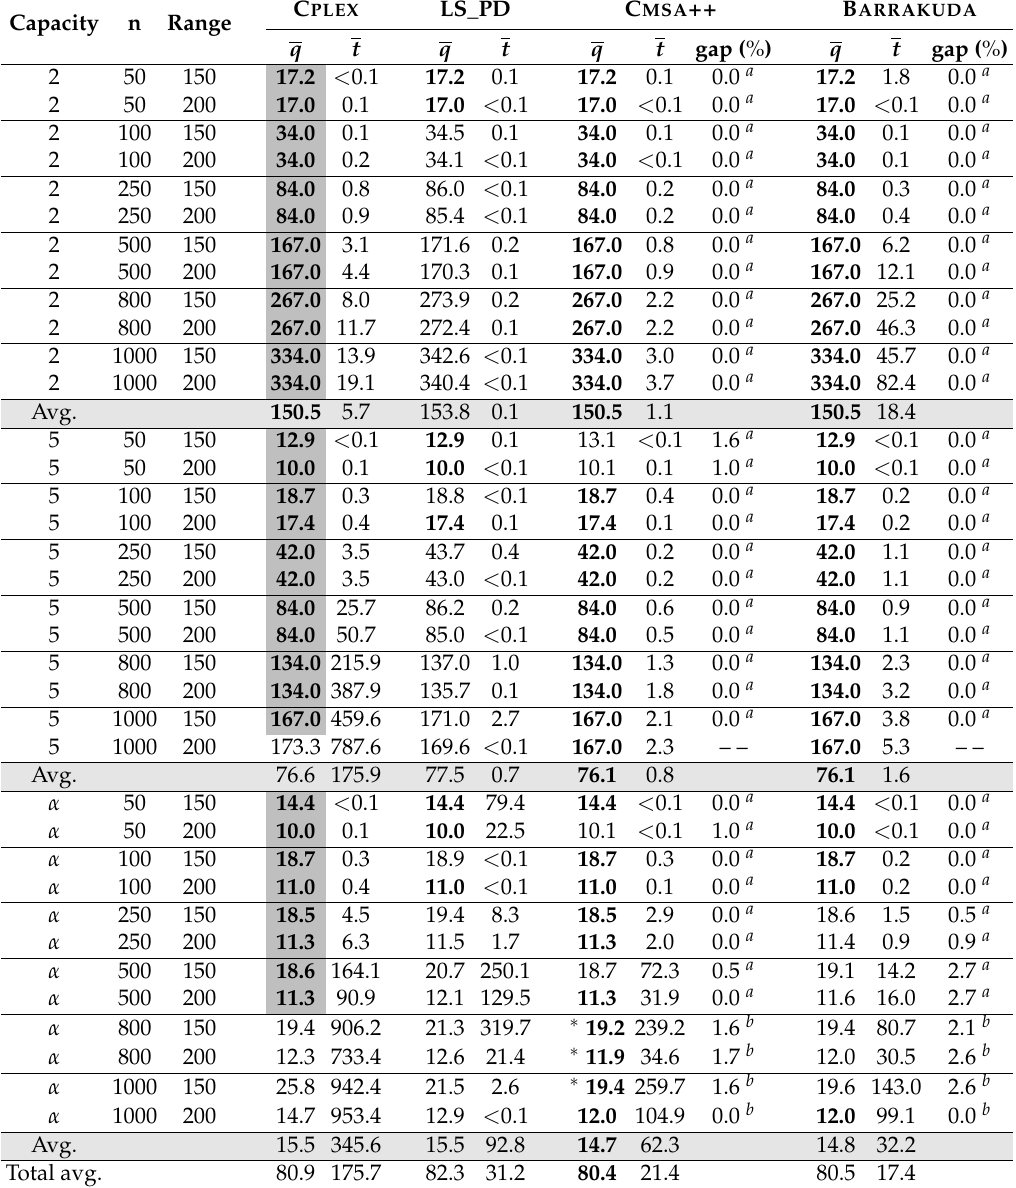
Table 7. Results for Unit Disk Graphs with uniform